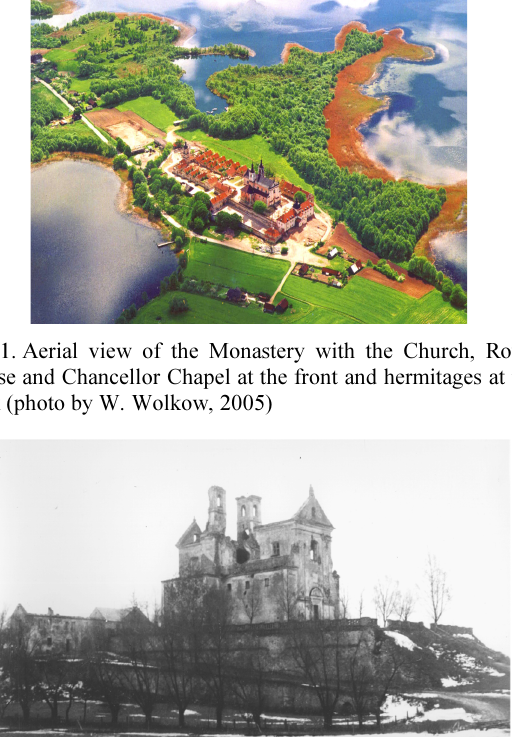
Fig. 2. Camaldolese Wigry Hill after the World War